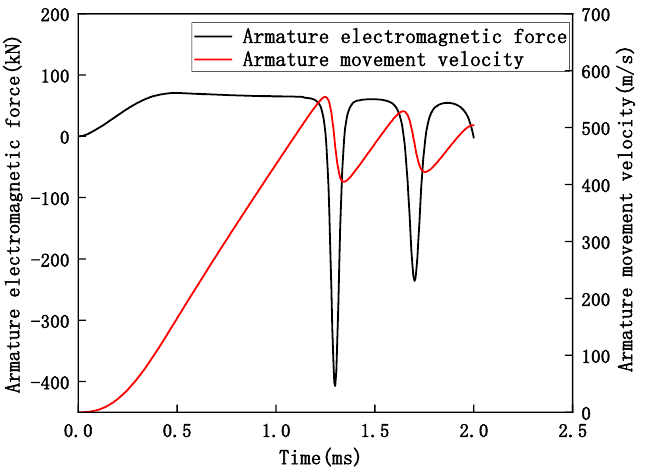
Figure 3. Calculated values of armature electromagnetic force and armature movement velocity.